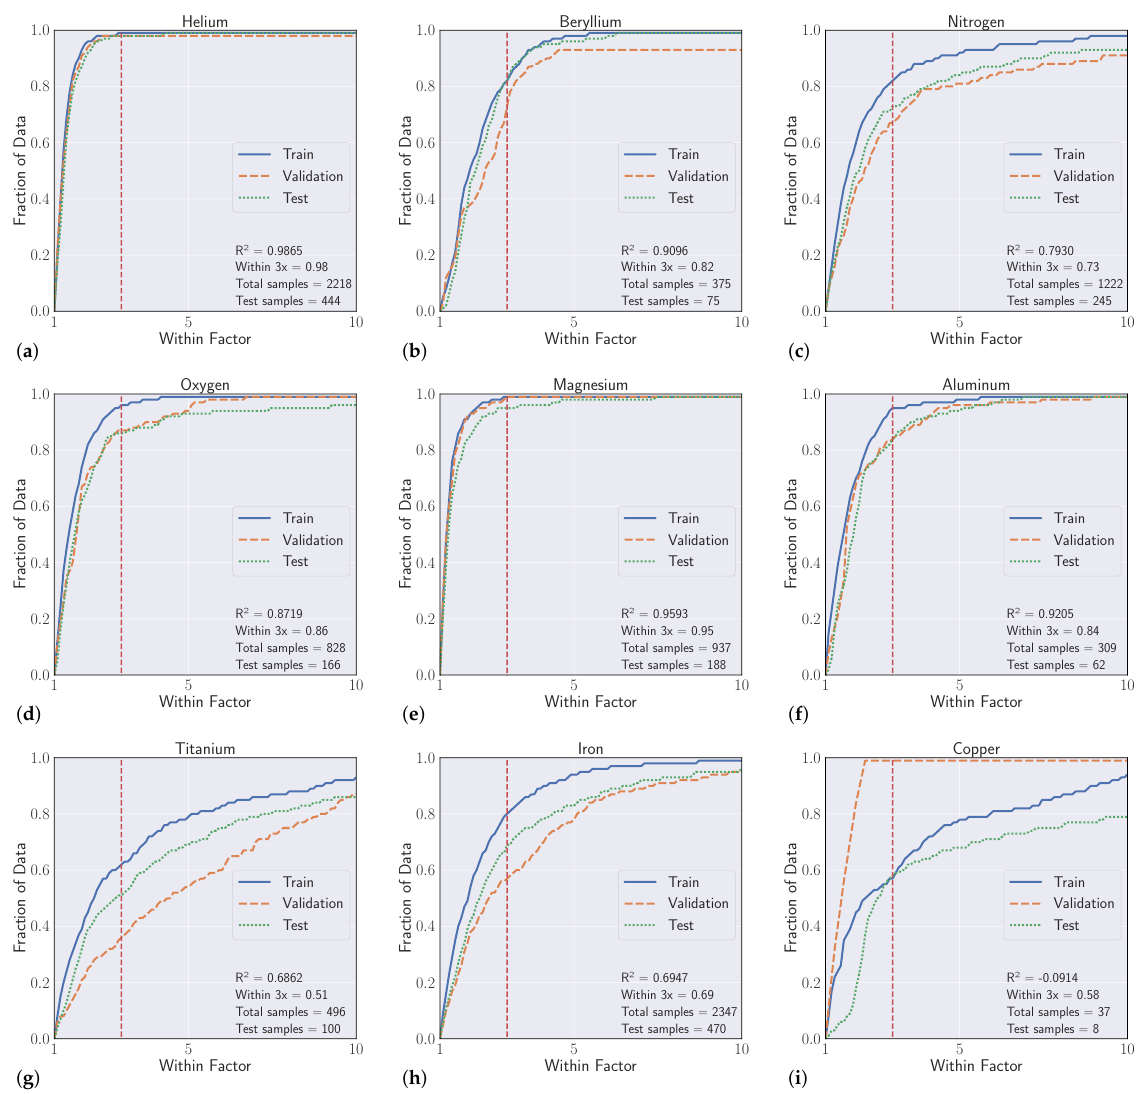
Figure 5. Performance of intraelement models showing fraction of transition probability predictions within a factor of the published value for training, validation, and testing